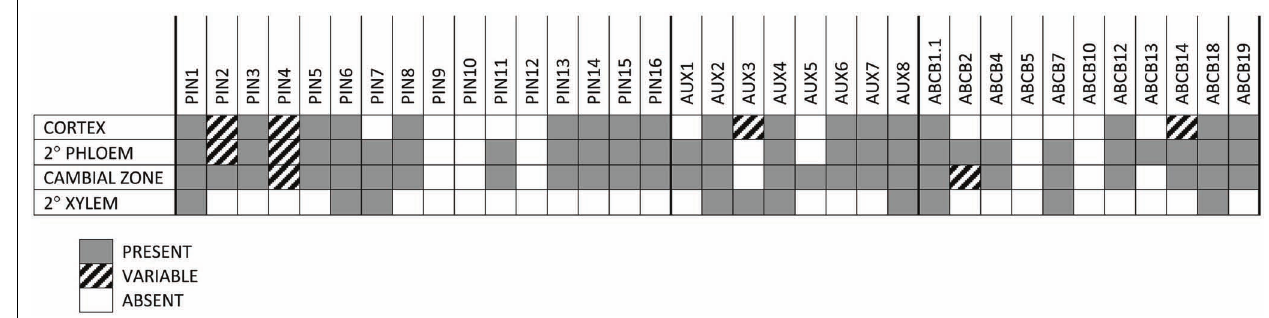
FIGURE 5 |Analysis of tissue-specific expression of PIN , AUX/LAX , and ABCB transcripts. Presence or absence of transcripts of genes coding for putative auxin transport proteins in the cortex, secondary phloem, cambial zone (i.e., initials and mother/daughter cells), and mature secondary xylem of Populus tremula × alba as determined by RT-PCR. Consensus of four